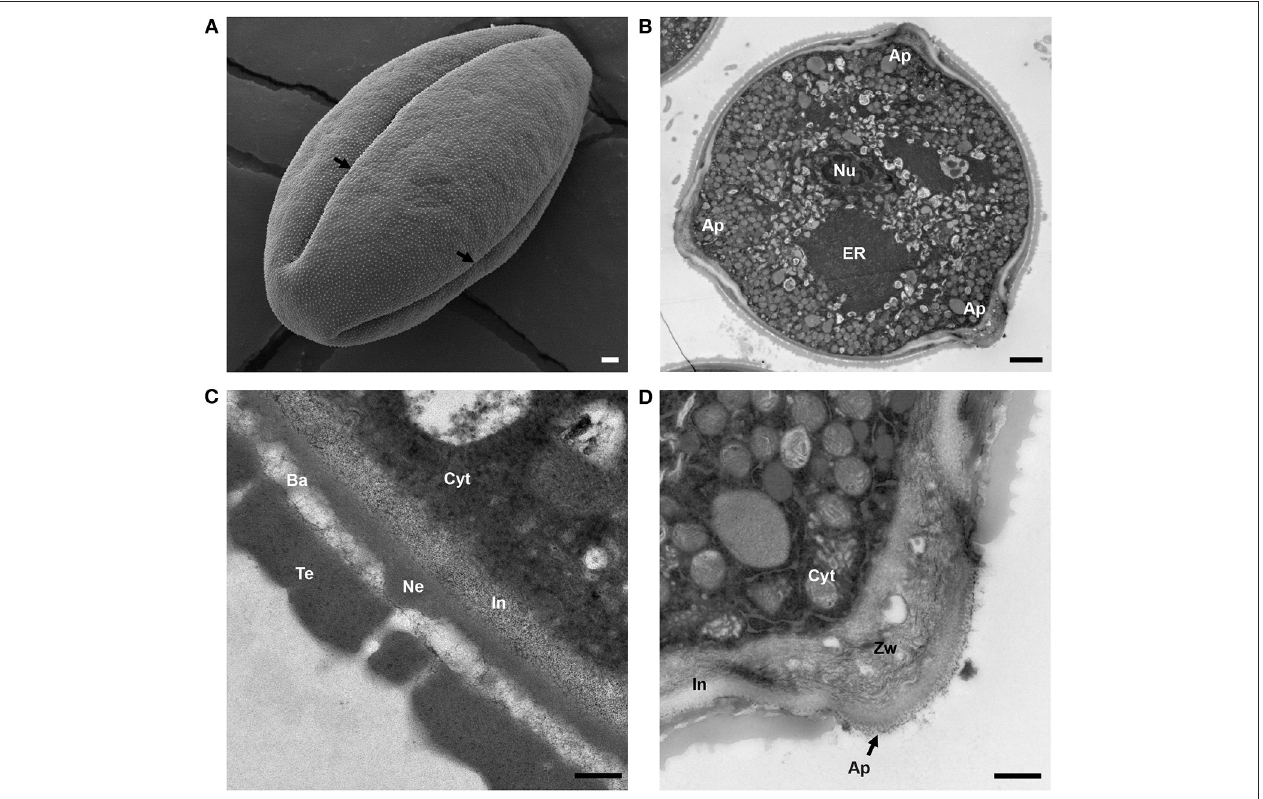
FIGURE 1 | Structure of mature tomato pollen grain. (A) Scanning electron micrograph of a mature, released tomato pollen grain. Arrows mark the apertures (Ap). (B) Transmission electron micrograph of a mature pollen grain cross section. Nu, nucleus; ER, endoplasmic reticulum; Ap, aperture. (C) TEM of mature pollen, showing the layers of the pollen wall. Cyt, cytoplasm; In, intine; Ne, nexine; Ba, bacula; Te, tectum. (D) TEM close-up of pollen aperture. Arrow marks the aperture. Cyt, cytoplasm; In, intine; Zw, zwischenkorper. Scale bars 1 µ m in (A) , 2 µ m in (B) , 200nm in (C) , and 600nm in (D)